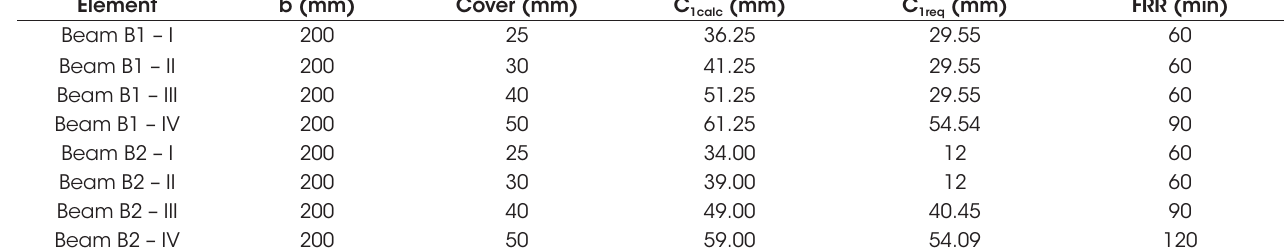
FRR attained though the tabular